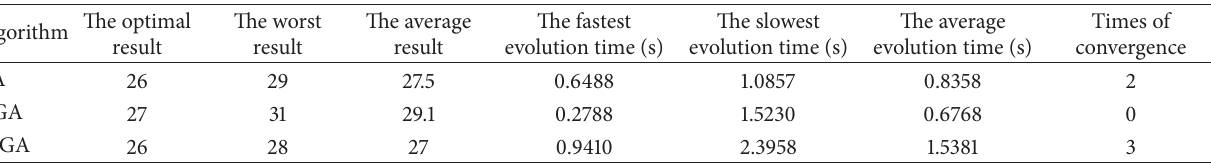
Table 9: The statistical results of the experiment.